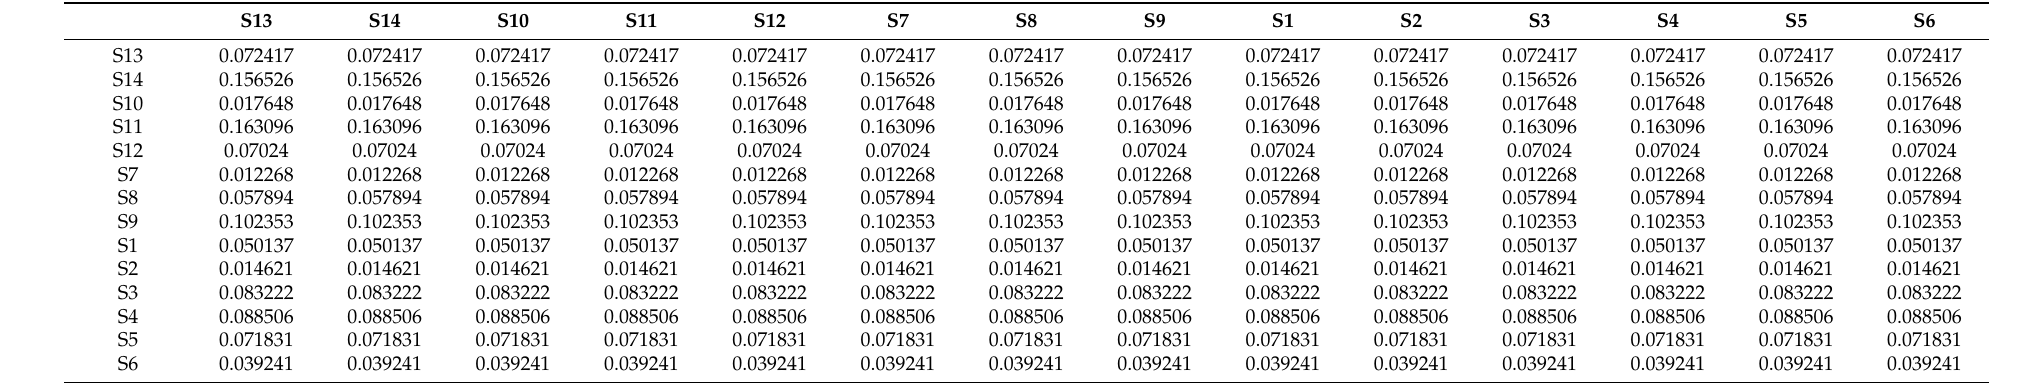
Table A3. Supermatrix for compatibility after convergence of